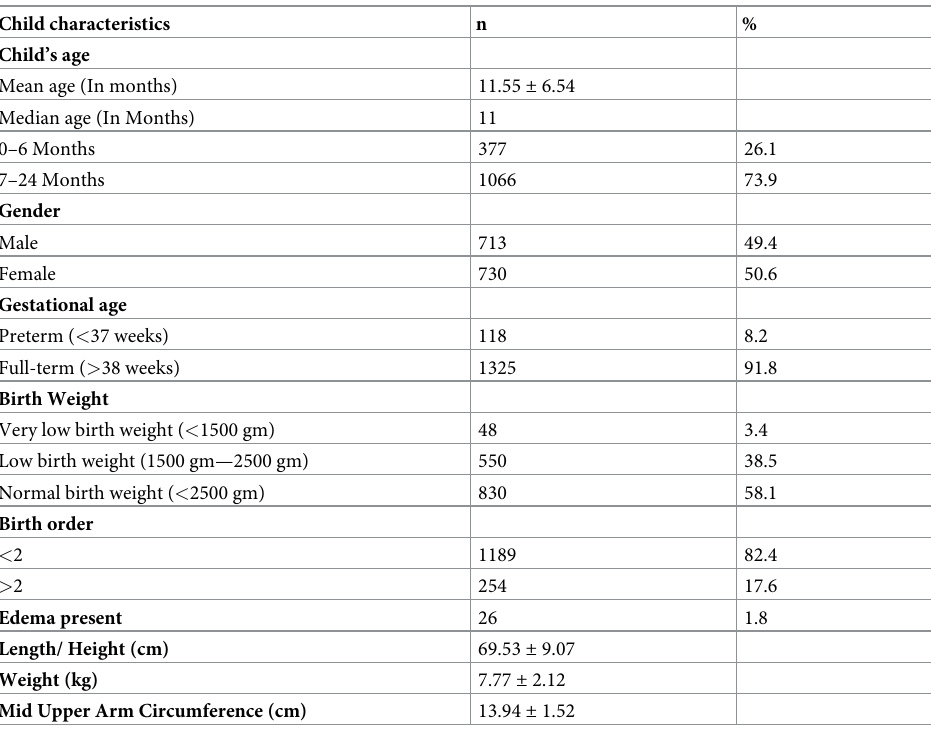
Table 2. Distribution of child characteristics (N = 1443).